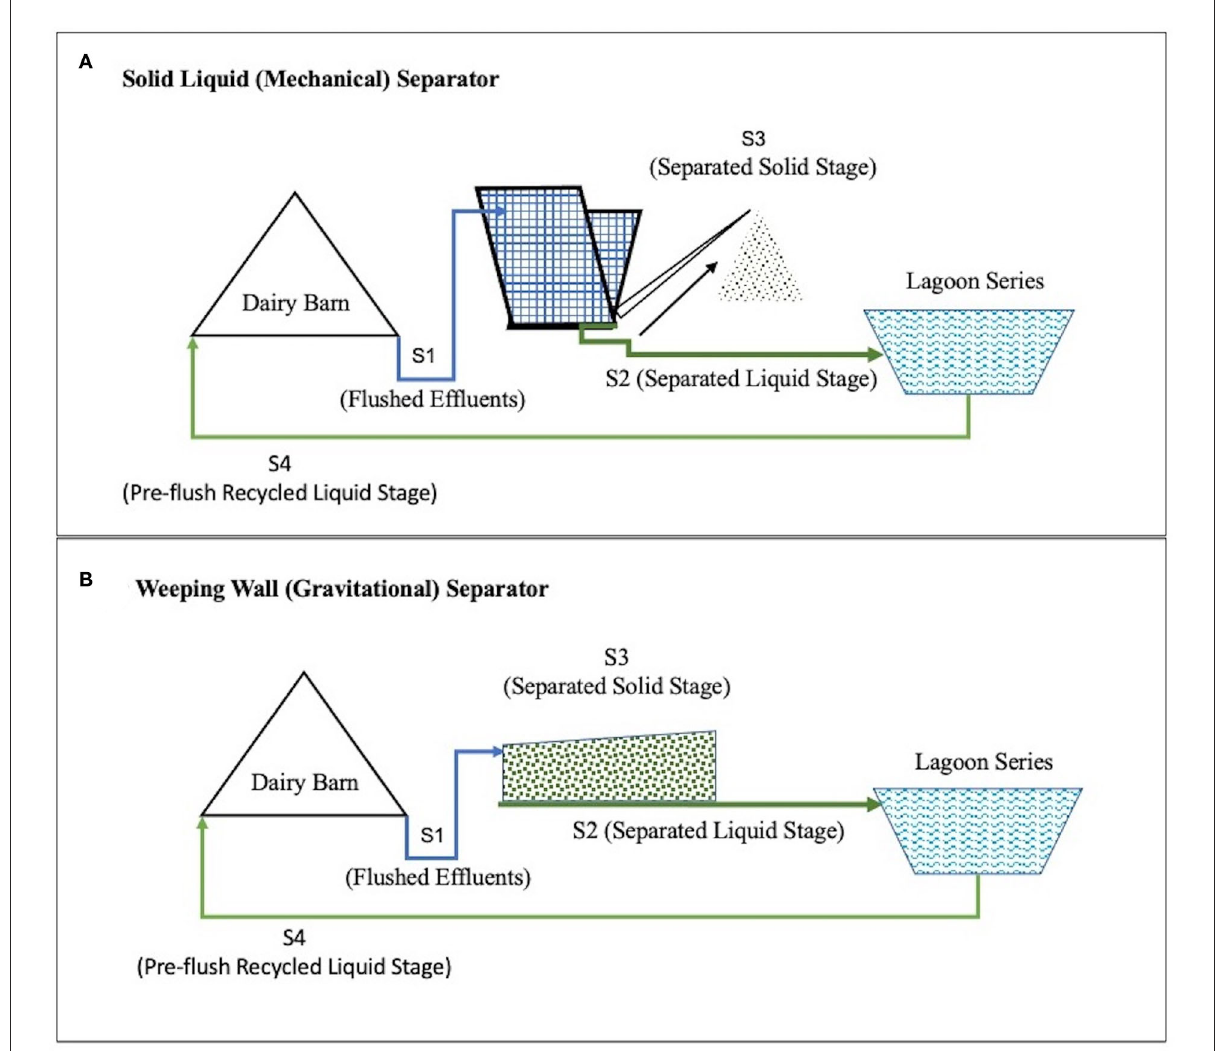
FIGURE1 Conceptual flow of manure in the two comparative Dairy Effluent Management Systems found on two partner farms from Central California, USA. The Dairy Effluent Management System in part (A) includes the Mechanical Solid Liquid Separator (SLS) System and the Effluent Management System in part (B) includes the gravitational Weeping Wall (WW)